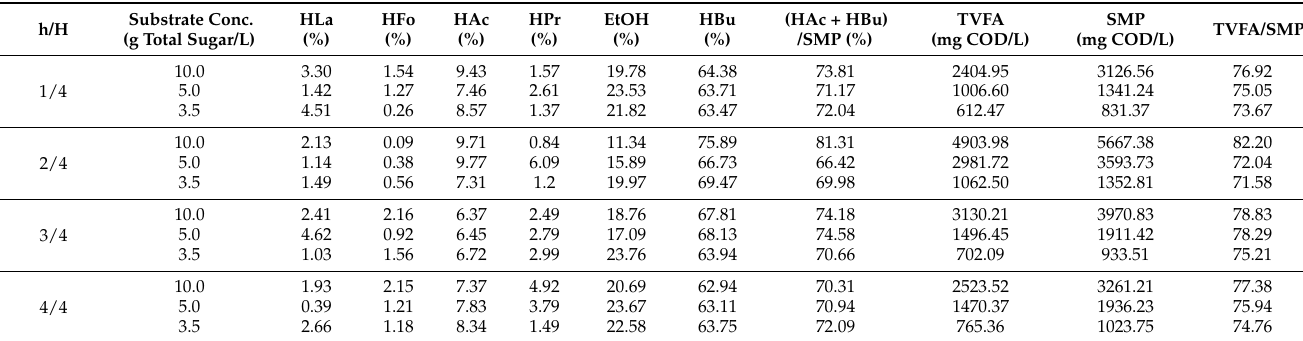
Table 4. Composition of the metabolites in the biohydrogen reactor under different packed-filter positions. h/H Substrate Conc. (g Total